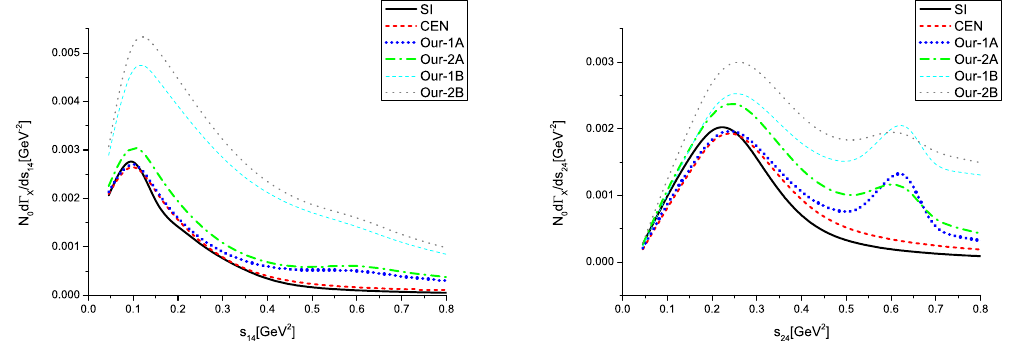
Figure 7 . Differential decay widths of the π − γ (left) and the π 0 γ (right) with E cut normalization factor N 0 is the inverse of the decay width of τ − → π − π 0 ν τ , i.e. N 0 = 1 / Γ The meanings of different curves are the same as those in figure